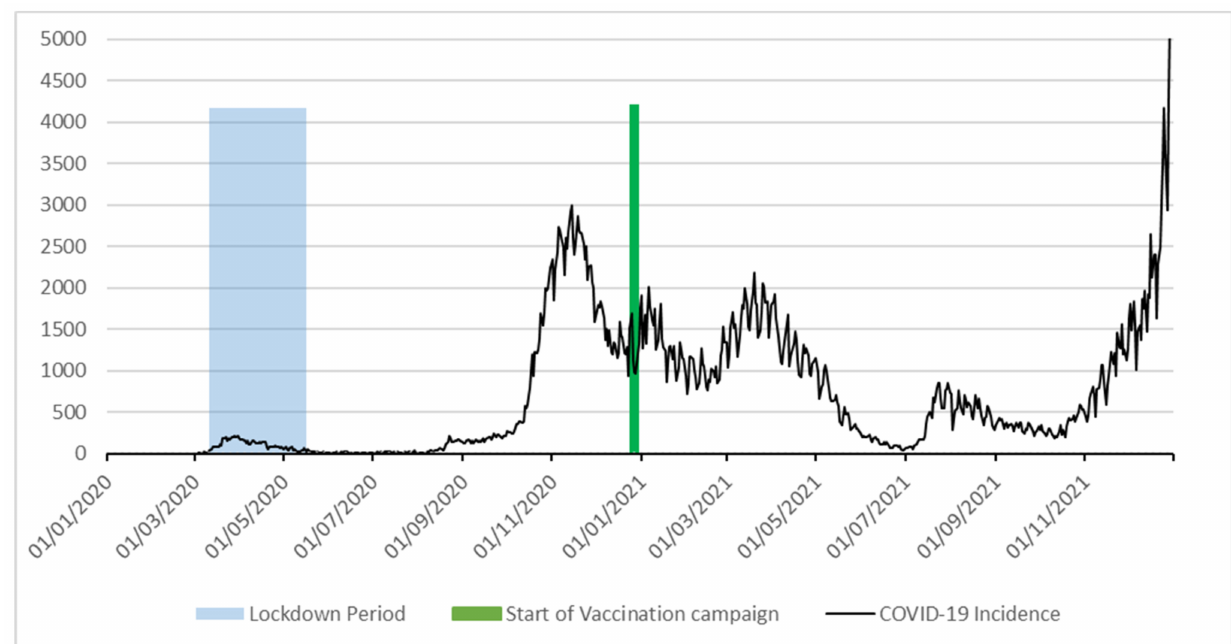
Figure 1. COVID-19 incidence in Lazio region, Italy, 2020–2021.